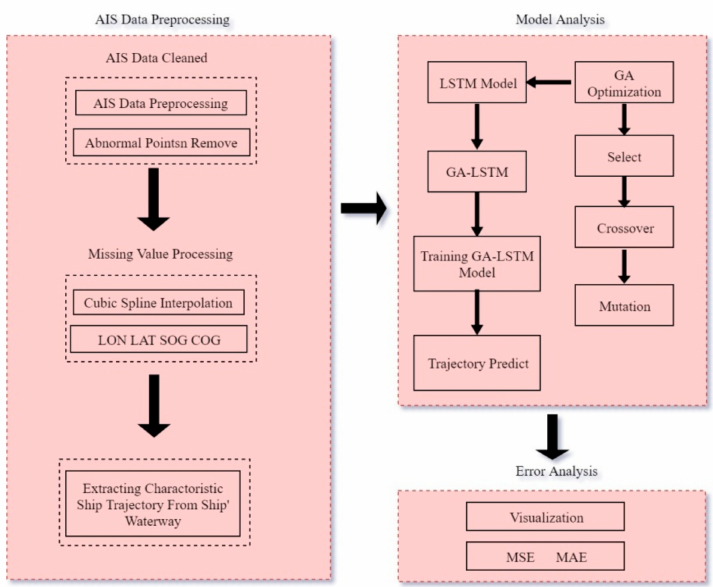
Figure 2. Flowchart of the vessel trajectory prediction